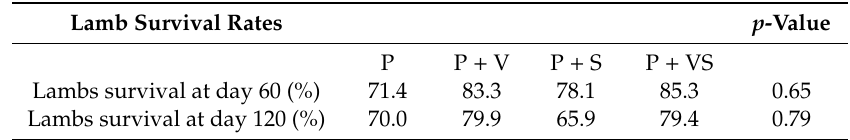
Table 2. E ff ects of maternal nutritional plane and vitamin C and E supplementation on survival rates at mid-lactation (60 days) and at weaning (120 days) of lambs born from twin-bearing ewes kept in extensive grazing under Patagonian